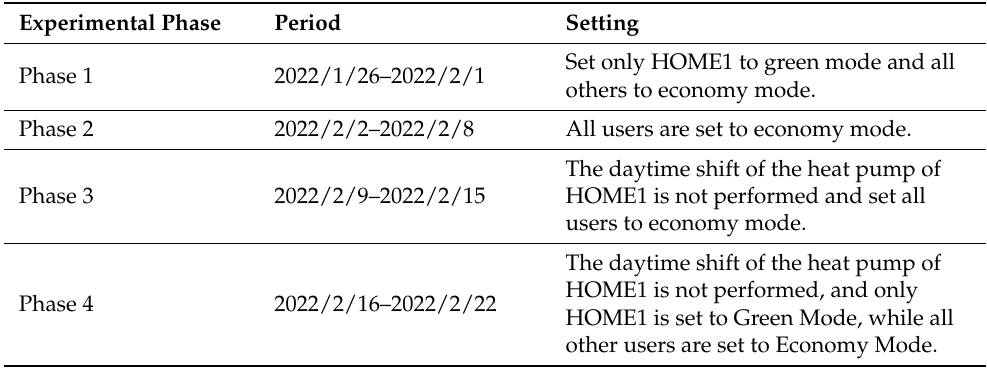
Table 3. Experimental phase and set